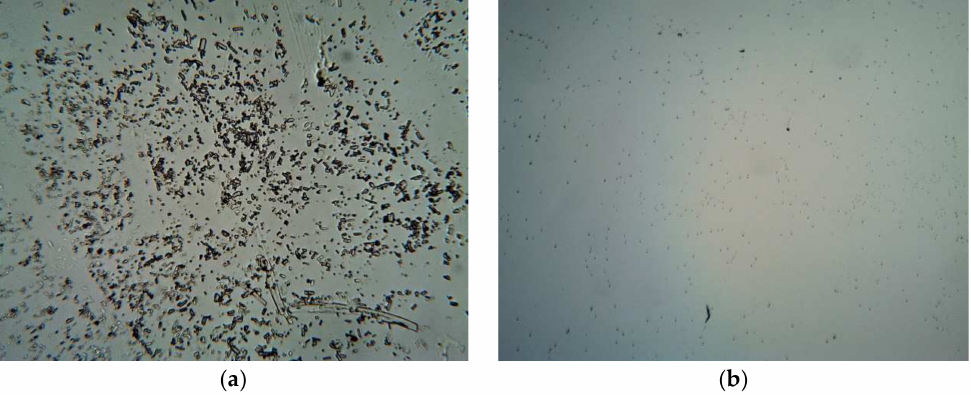
Figure 5. Images of optimized formulation under light microscope at 10X: ( a ) gel containing 1.5% w / w of TBN and ( b ) gel containing 1.2% w / w of